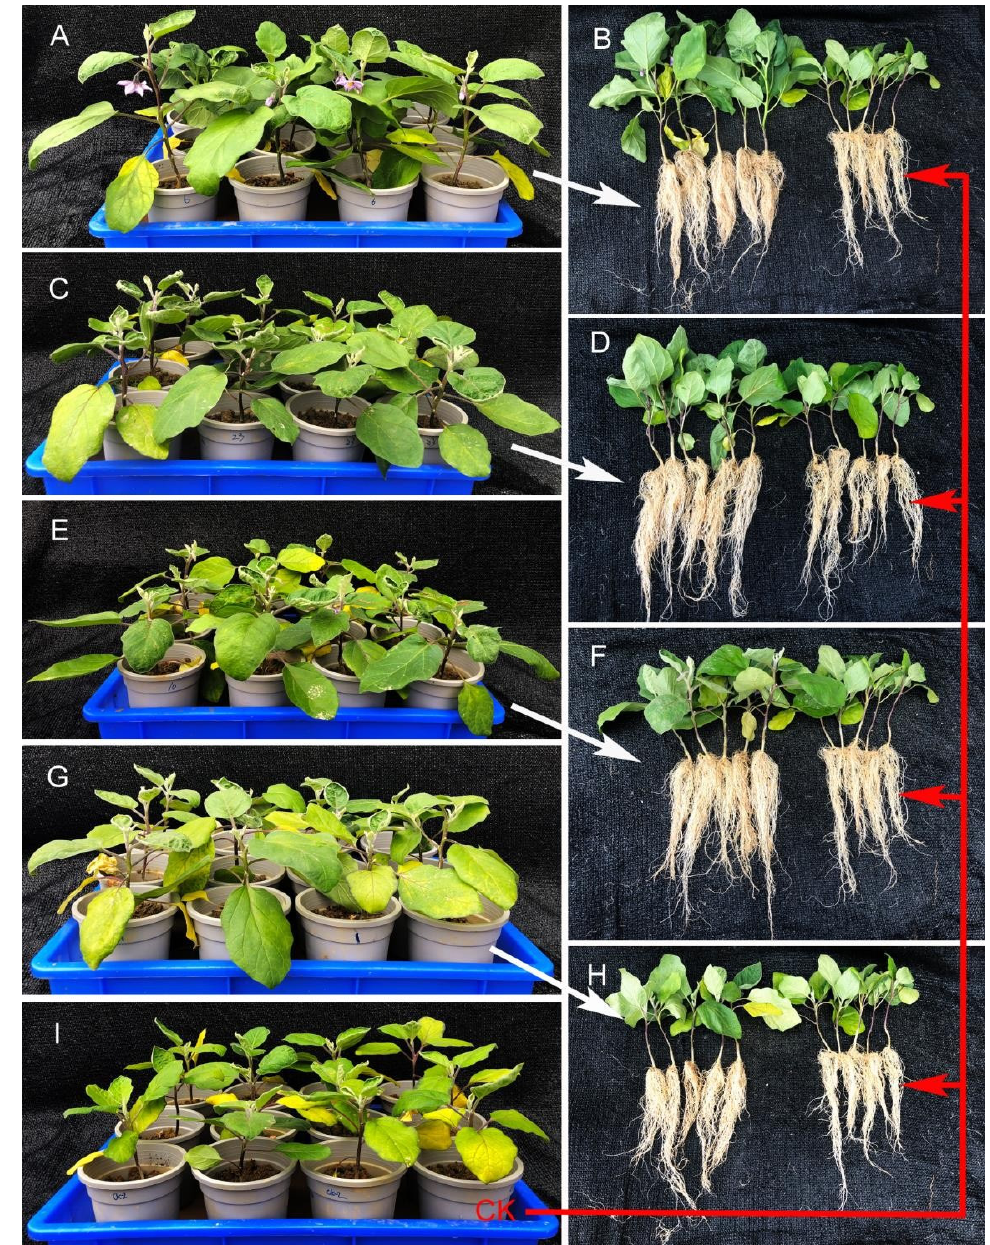
Figure 9. Effect of inoculation with four fungal isolates on eggplant growth in soil from new reclamation land 30 days after inoculation. Each treatment had three replicates with 30 plants in each replicate. The photos of plants were taken by randomly placing 12 plants from each treatment into one tray, while the photos of roots were taken by randomly picking up 5 plants from each treatment and then removing the soil from the roots. All control plants come from the uninoculated control treatment. ( A ) Inoculation with isolate HZ06; ( B ) roots from A; ( C ) inoculation with isolate HZ23; ( D ) roots from C; ( E ) inoculation with isolate HZ10; ( F ) roots from E; ( G ) inoculation with isolate HZ123; ( H ) roots from G; ( I ) the uninoculated control.